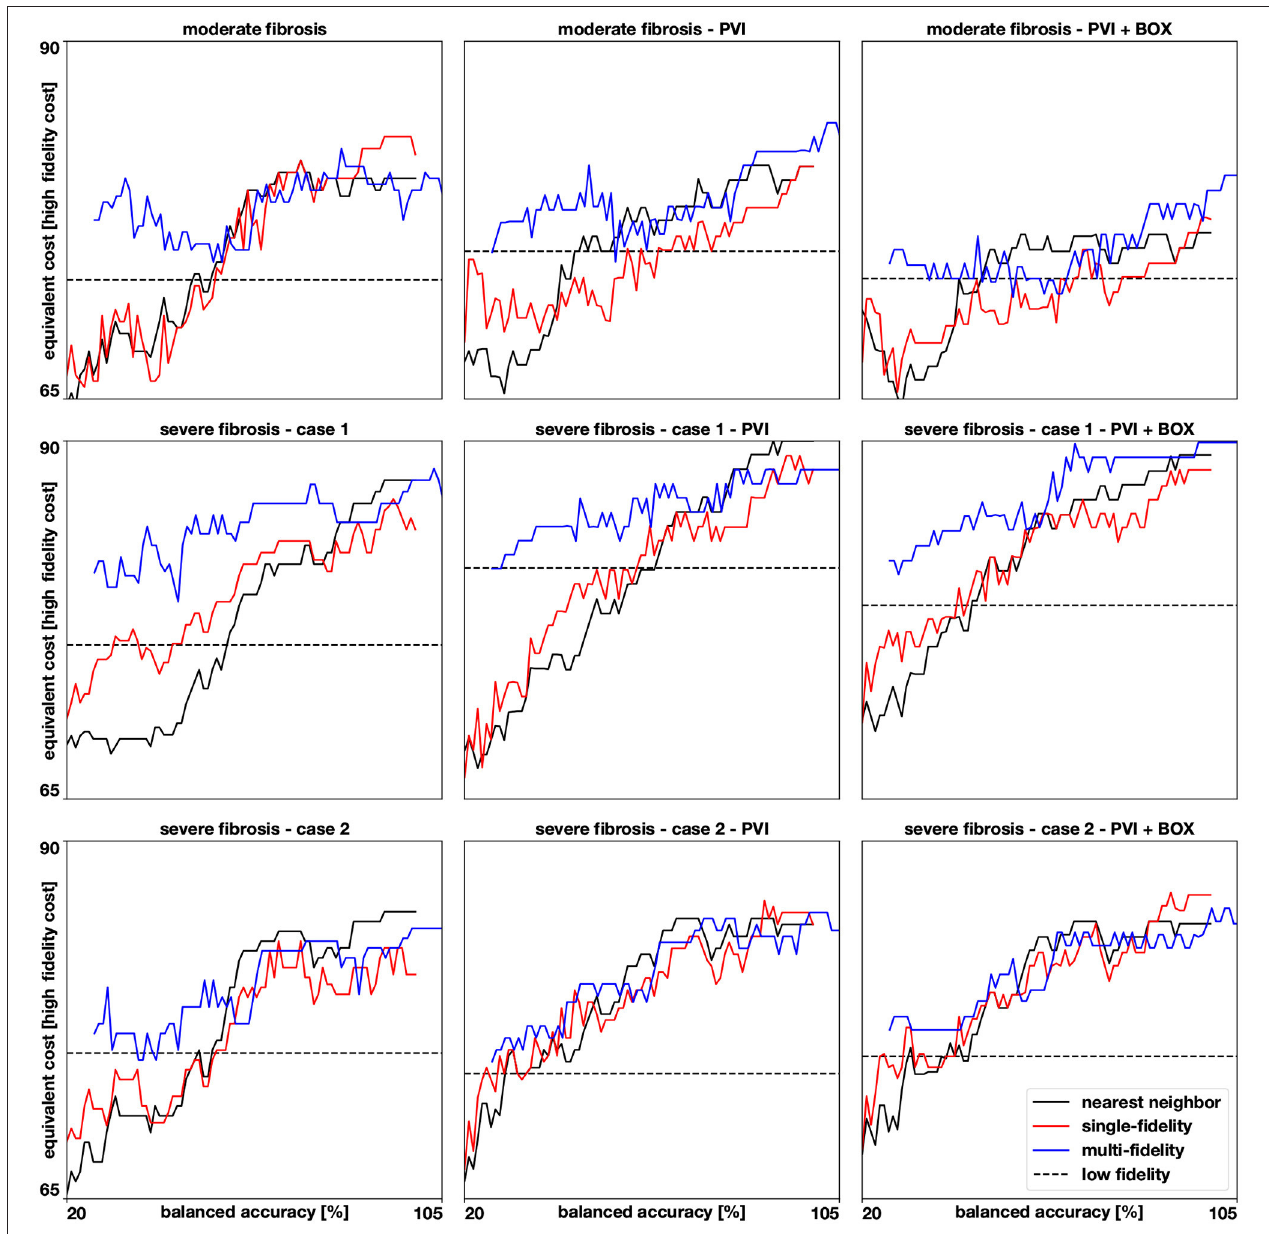
FIGURE 8 | Accuracies for 9 different cases. We show how the balanced accuracy evolves as more samples (from 20 to 100) are available for the multi-fidelity, single-fidelity, and nearest neighbor classifiers. The samples are represented as the cost of running a high fidelity model and the multi-fidelity curve is shifted to the right to account for the cost of 100 low fidelity simulations. The dashed horizontal line represents the accuracy of a Gaussian process classifier trained with 100 low fidelity simulations predicting the high fidelity test